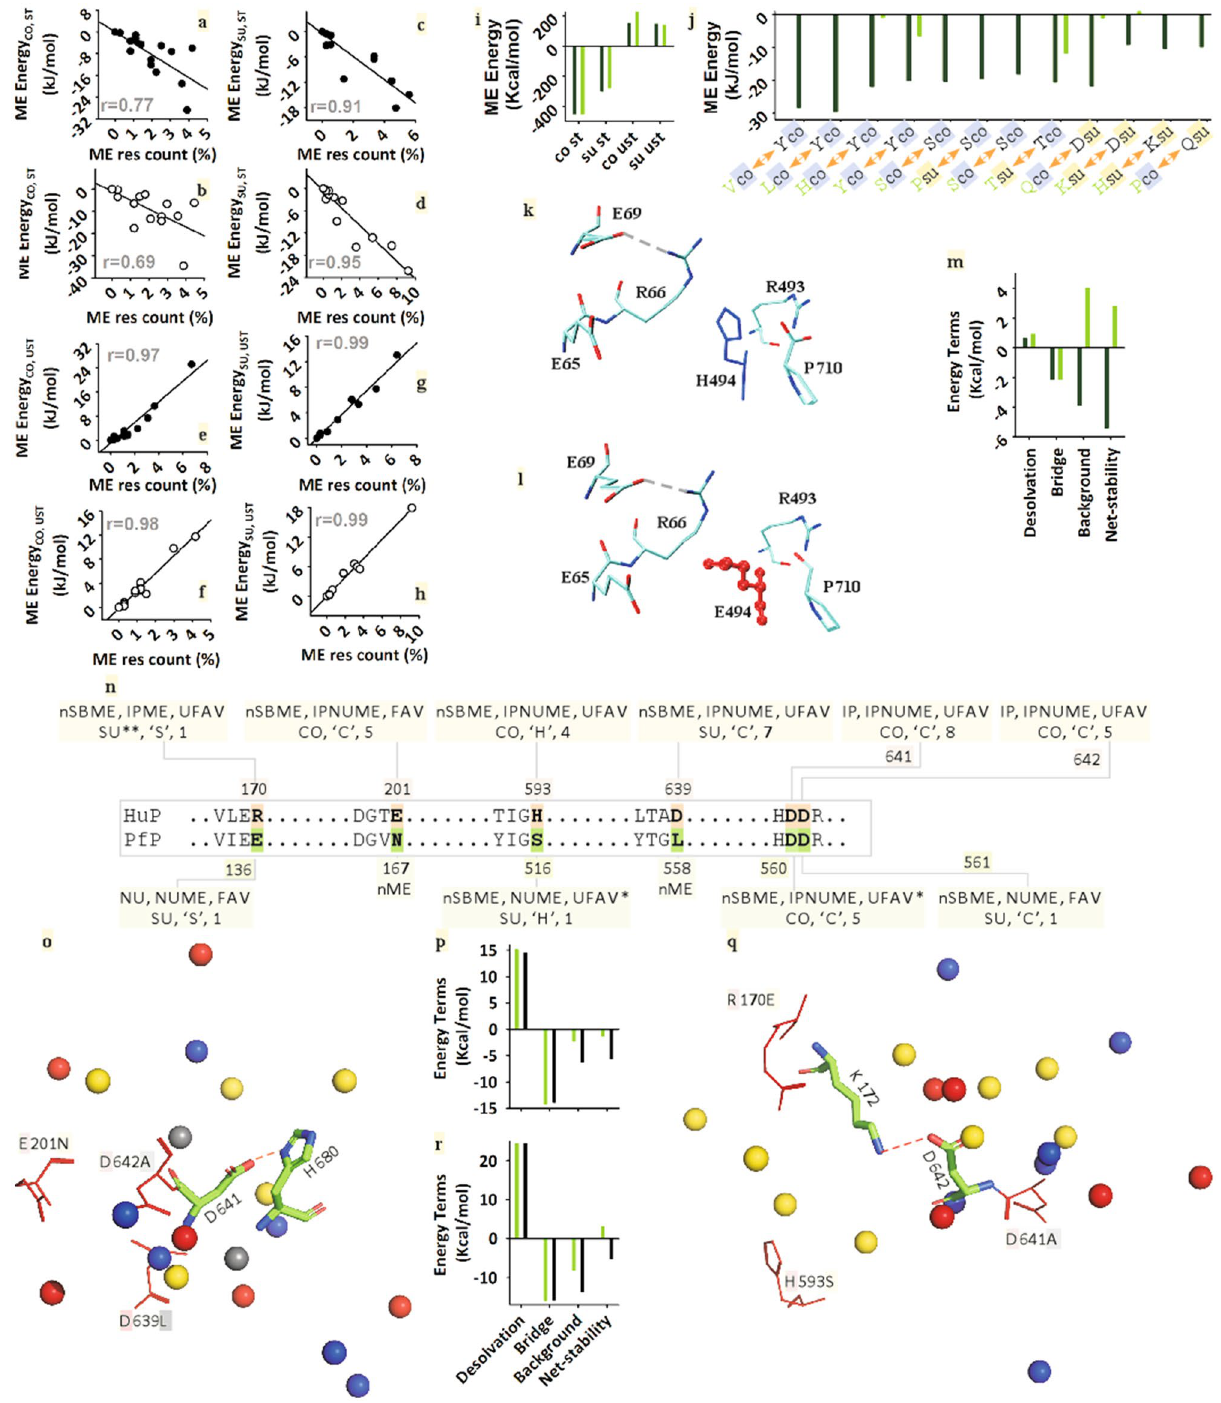
Figure 4. Distribution at the core and surface of 5t88 and 3ddu’s ME-residues, and their correlation, interaction- energy, and mutagenesis. 3ddu’s (black circle) core’s stable (CO, ST) ( a ), surface’s stable (SU, ST) ( c ), core’s unstable (CO, UST) ( e ), surface’s unstable ( g ) (SU, UST) ME-candidates are compared with 5t88’s (empty circle) core’s stable ( b ), surface’s stable ( d ), core’s unstable ( f ), surface’s unstable ( h ) ME-candidates, respectively. Comparison of 5t88 (black bar) and 3ddu’s (green bar)) core (CO) and surface (SU) stable (ST) and unstable (UST) ME-candidates ( i ). Especially in selected ME-candidates of core (blue) and some surfaces (yellow), which are derived from homologous substitution in sequence and, which are favorable to 5t88 (black bar) in respect of 3ddu (green bar) ( j ). Salt-bridge and ME-residues of Wild ( k ) and Mutant ( l ) 3ddu protein where H494 (blue) was mutated by E494 (red). Wild (green bar) and mutant (black bar) 3ddu’s components and net energy terms ( m ). Compared to PfP, some of HuP’s homologous unfavorable ME-residues and their binary details ( n ). Acidic (red), basic (blue), polar (yellow), and hydrophobic (grey) ME-residues of the salt-bridge, D641-H680 ( o ). Here, the residues that are used for the cumulative replacements are shown by redsticks. The energy terms of the mutant (black) and wild-type HuP ( p ). A similar presentation of ME residues ( q ) and energy terms ( r ) are shown for the salt-bridge,